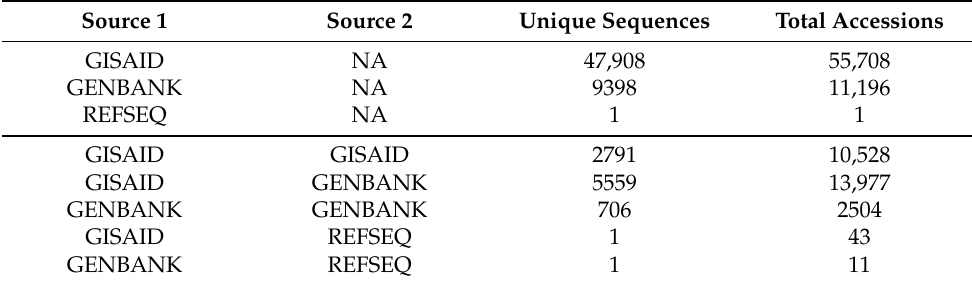
Table 1. Distribution of Duplicated Genome Sequences. The number of unique genome sequences and total genome accessions (count of all entries) are listed for each source: GISAID, GenBank, and NCBI RefSeq. Pairwise comparisons are then made for each genome sequence to indicate how many times a genome sequence is duplicated within its source or between sources and for how many entries this accounts for (total accessions). For RefSeq comparisons, note that only one SARS-CoV-2 reference genome sequence is available